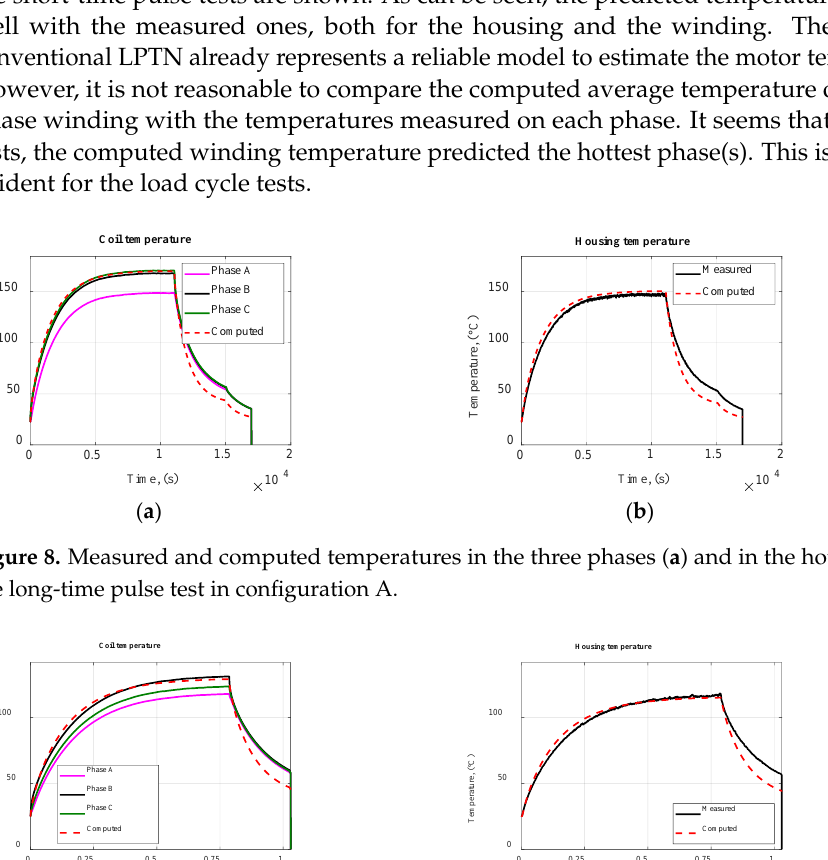
( b ) Figure 10. Measured and computed temperatures in the three phases ( a ) and in the housing ( b ) for the short-time pulse test in configuration A. ( a ) ( b ) Figure 11. Measured and computed temperatures in the three phases ( a ) and in the housing ( b ) for the short-time pulse test in configuration B. In Figures 12 and 13, the measured and the computed temperatures for the two load cycles are reported. The obtained results showed less accuracy in comparison with the pulse tests’ results, even if the R hsg was adjusted as indicated in Table 2, when the machine was inside the climatic chamber. On the basis of the obtained results, the definition of an LPTN that can predict the temperatures of the three phases distinctly may be a worthy improvement for this kind of application. In order to develop such an LPTN, a prelimi- nary investigation on the unbalanced heating of the machine was carried out. For this reason, a finite element model of the motor was created and supplied with different values of Joule losses on the three phases.